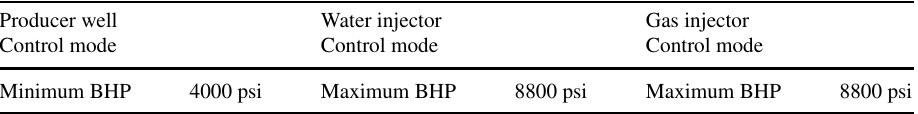
Table 3 Operational restrictions of the